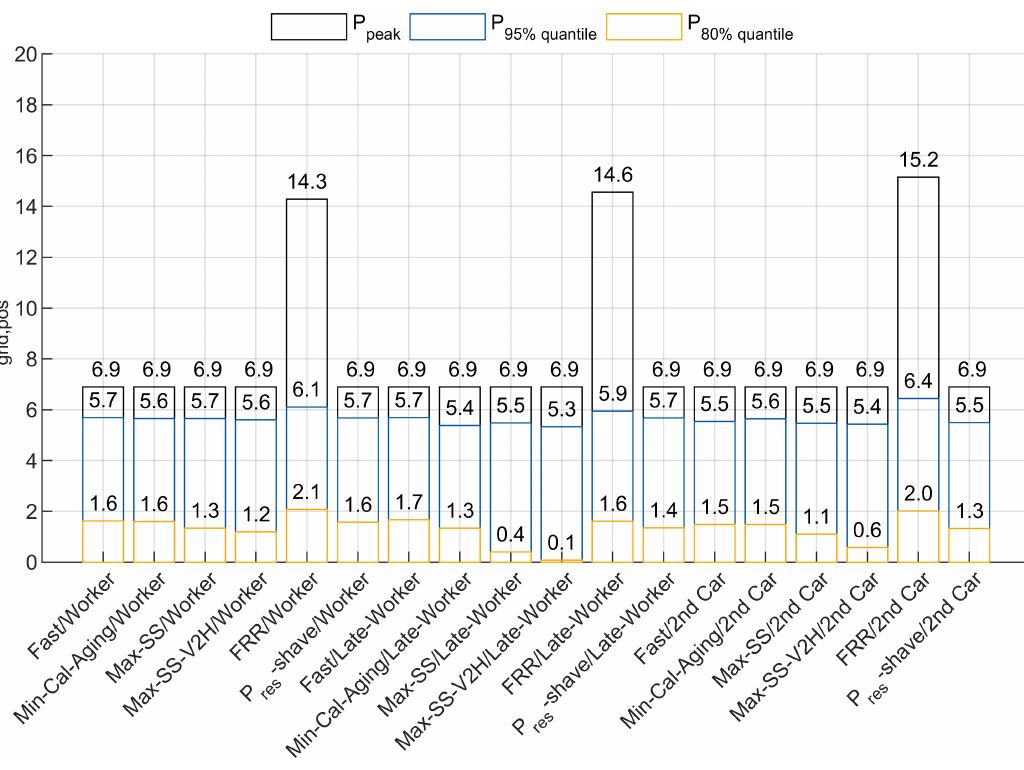
Figure A6. Positive power exchange of the household with the grid for home charging scenario H without SoC V 2 XLimit